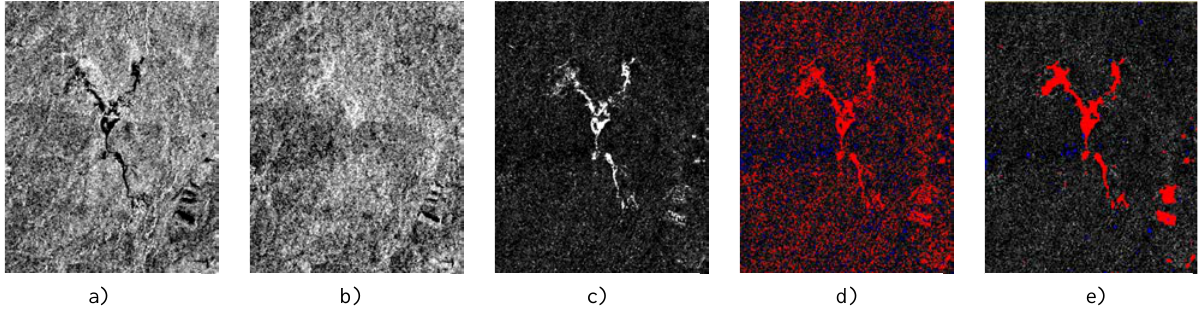
Figure 1 : Study area of Queensland, Australia. Subsets of TerraSAR-X amplitude data (© DLR 2013) of a) 05/01/2011 and b) 21/01/2011, c) intensity ratio image between b) and a), d) classification based on the hypothesis test, e) classification based on the hypothesis test and the graph-cut algorithm. In d) and e) positive- and negative-change are shown in red and blue colors, no-change is transparent.